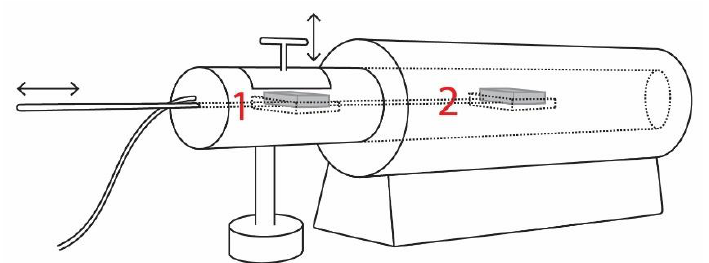
Figure 1. Schematic image of the in-house modified Carbolite furnace CTF/12/65 used for sintering. In the setup, the lid is opened and graphite mold with glass is first placed in a holder in a nitrogen- filled, nonheated chamber (1) before the holder is pushed to the middle of the furnace for sintering (2). Image not to scale.